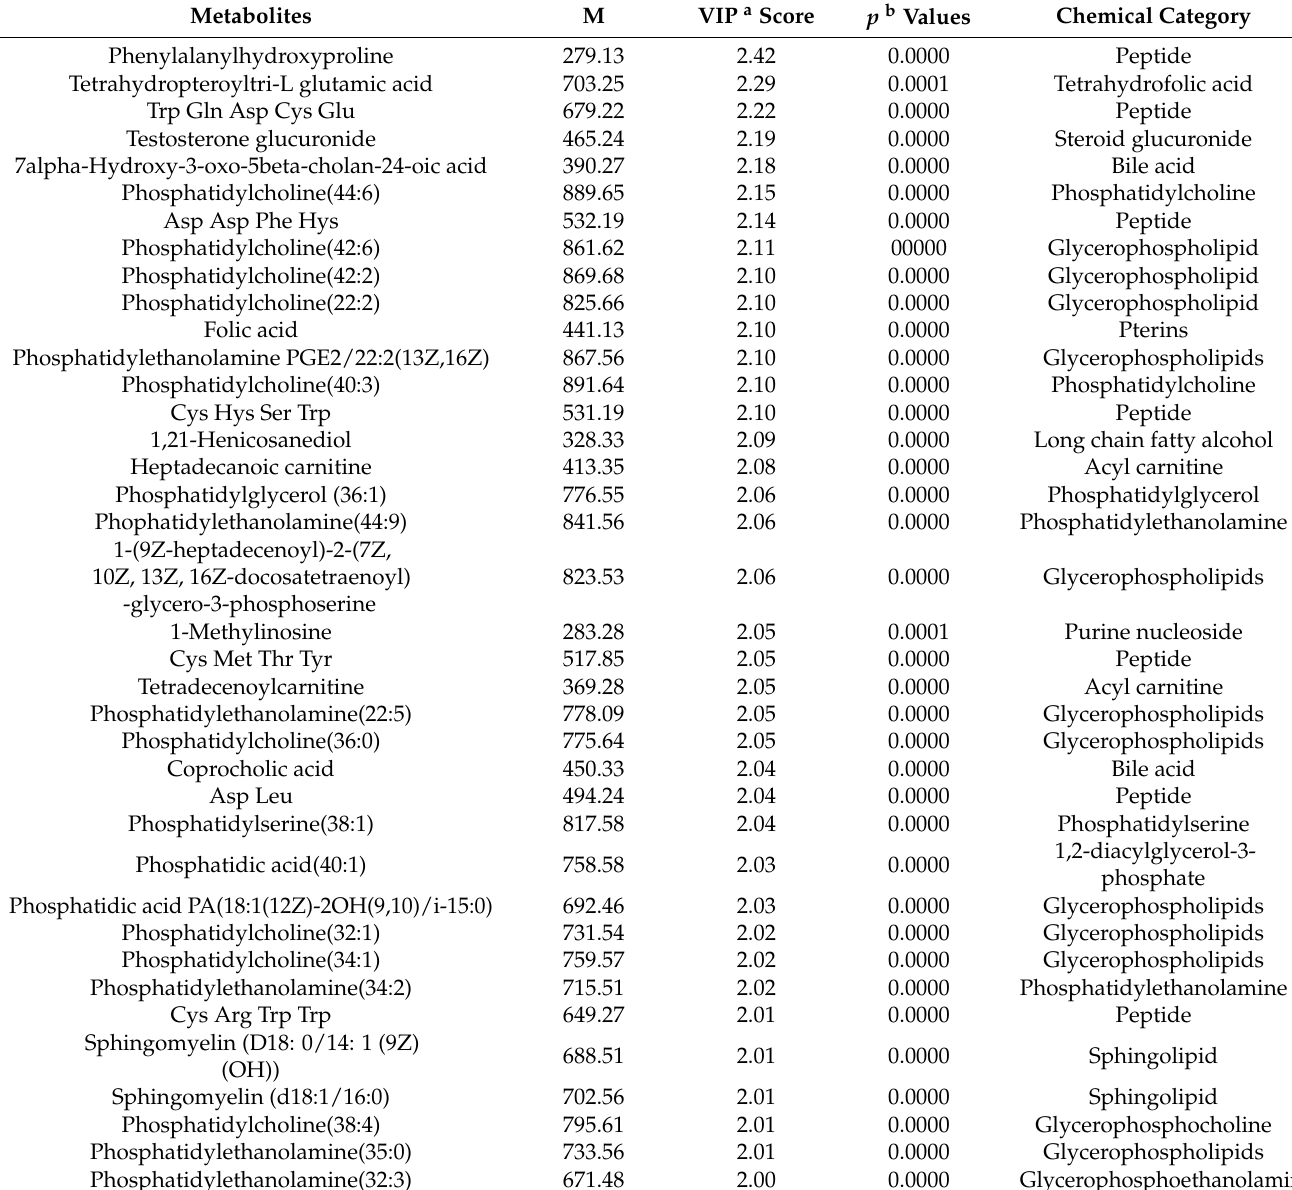
Table 2. Identification of urinary metabolic biomarkers related to exposure to low concentrations of